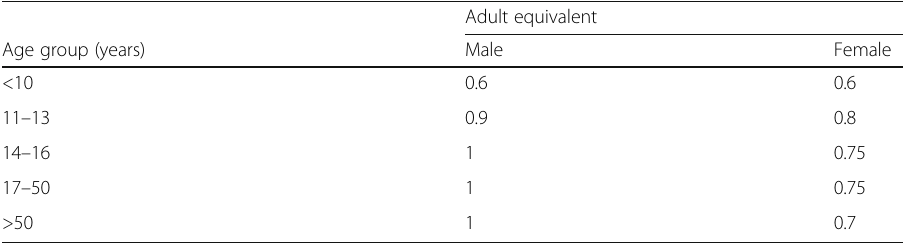
Table 7 Conversion factor for computation of adult equivalent